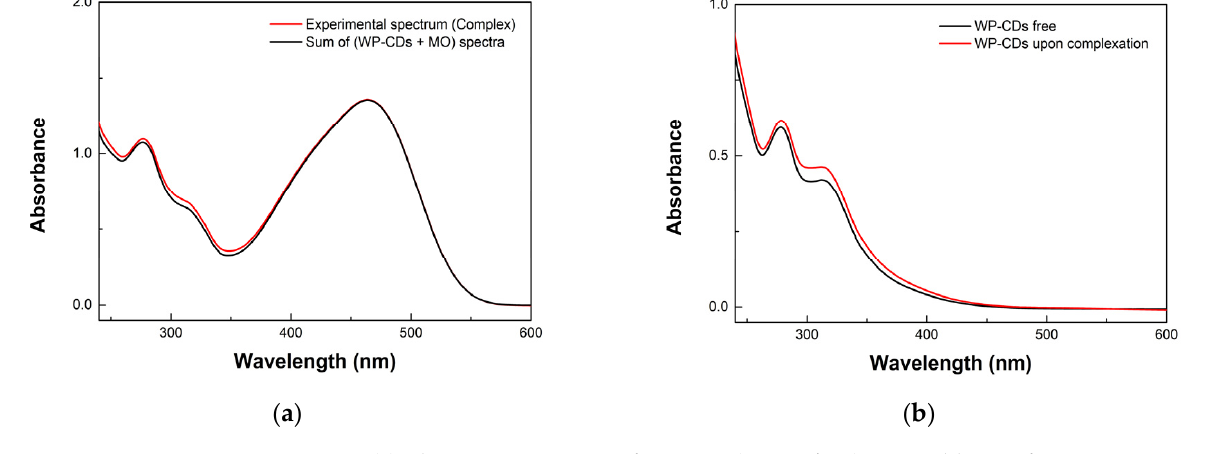
Figure 7. ( a ) Absorption spectrum of WP-CDs (0.1 mg/mL) upon addition of MO in a concentration of 52.4 µ M in phosphate buffer (pH = 7.2) (red line) and the sum of the absorption spectra of each component taken separately (black line) under the same experimental conditions. ( b ) Absorption spectrum of WP-CDs alone (black line), and that obtained by subtraction of the MO spectrum from that obtained upon complexation (red line).